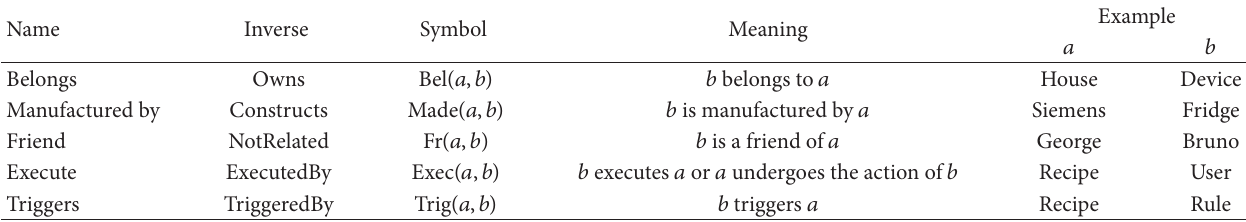
Table 1: Semantic relations used for generation of combined relation 𝑅 𝐶